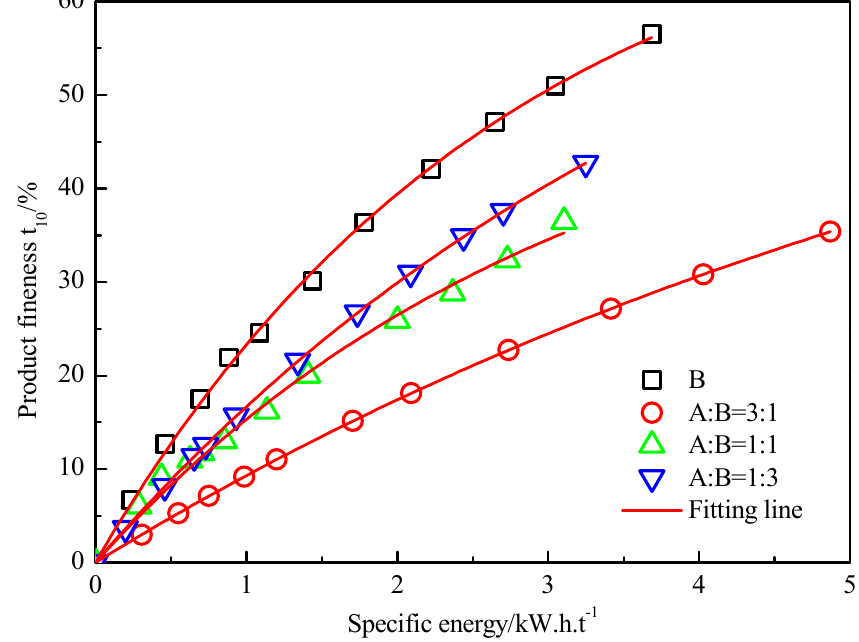
Figure 9. Specific energy vs product fineness t 10 of bituminous coal in mixture breakage.